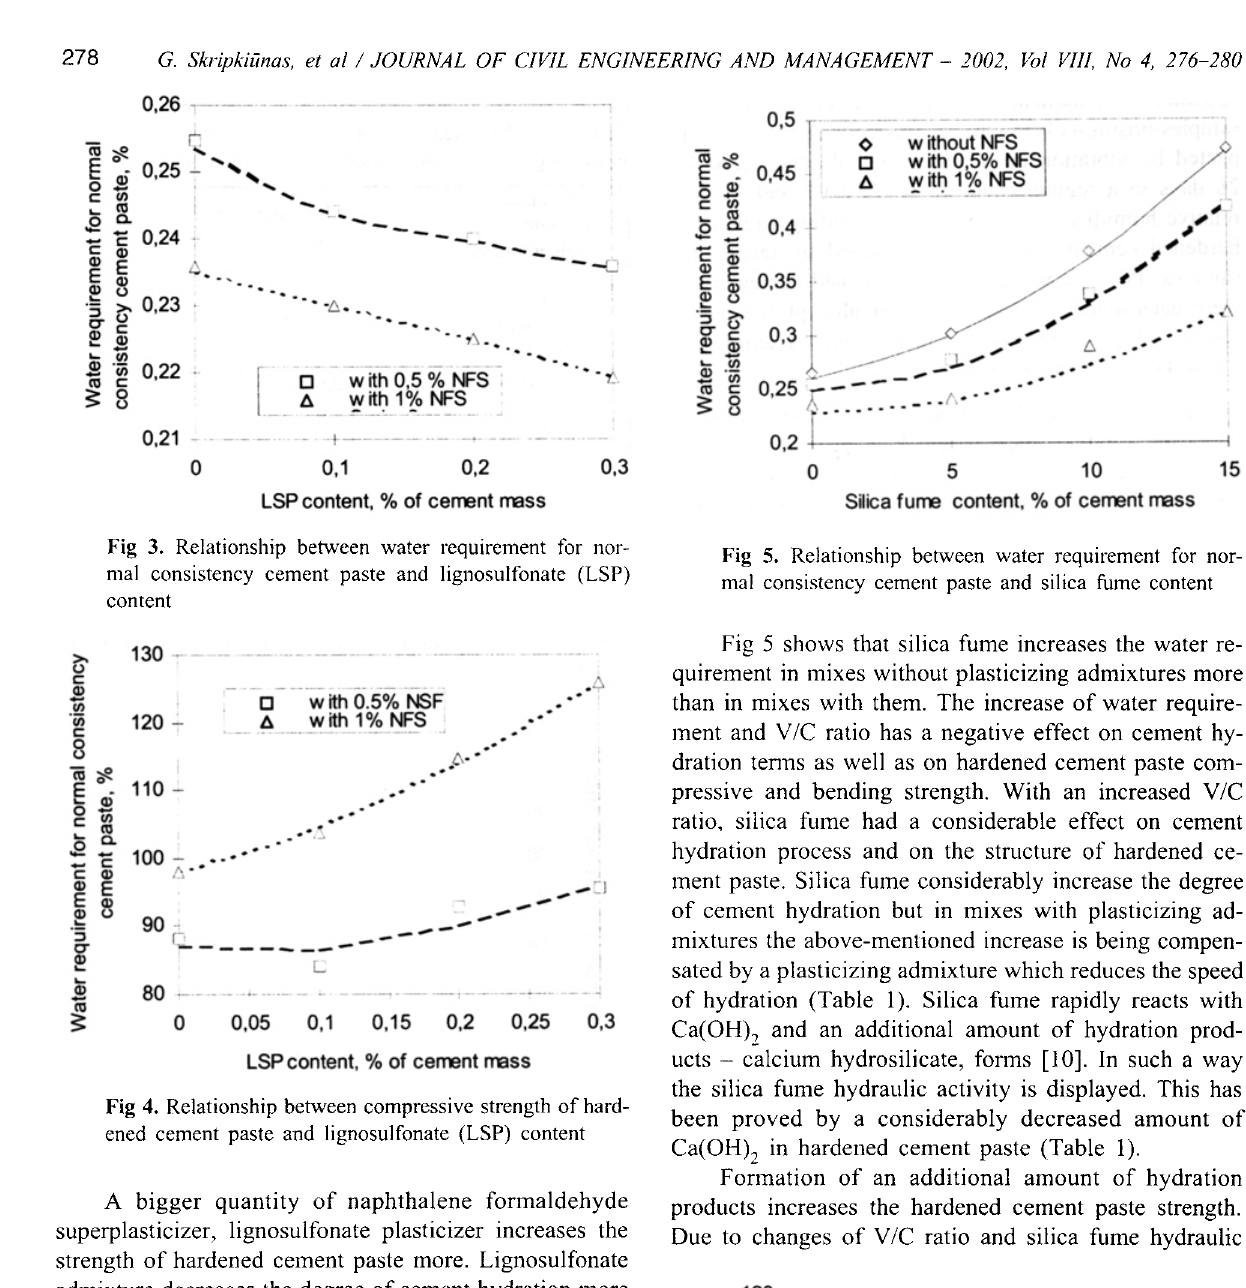
Fig 4. Relationship between compressive strength of hard